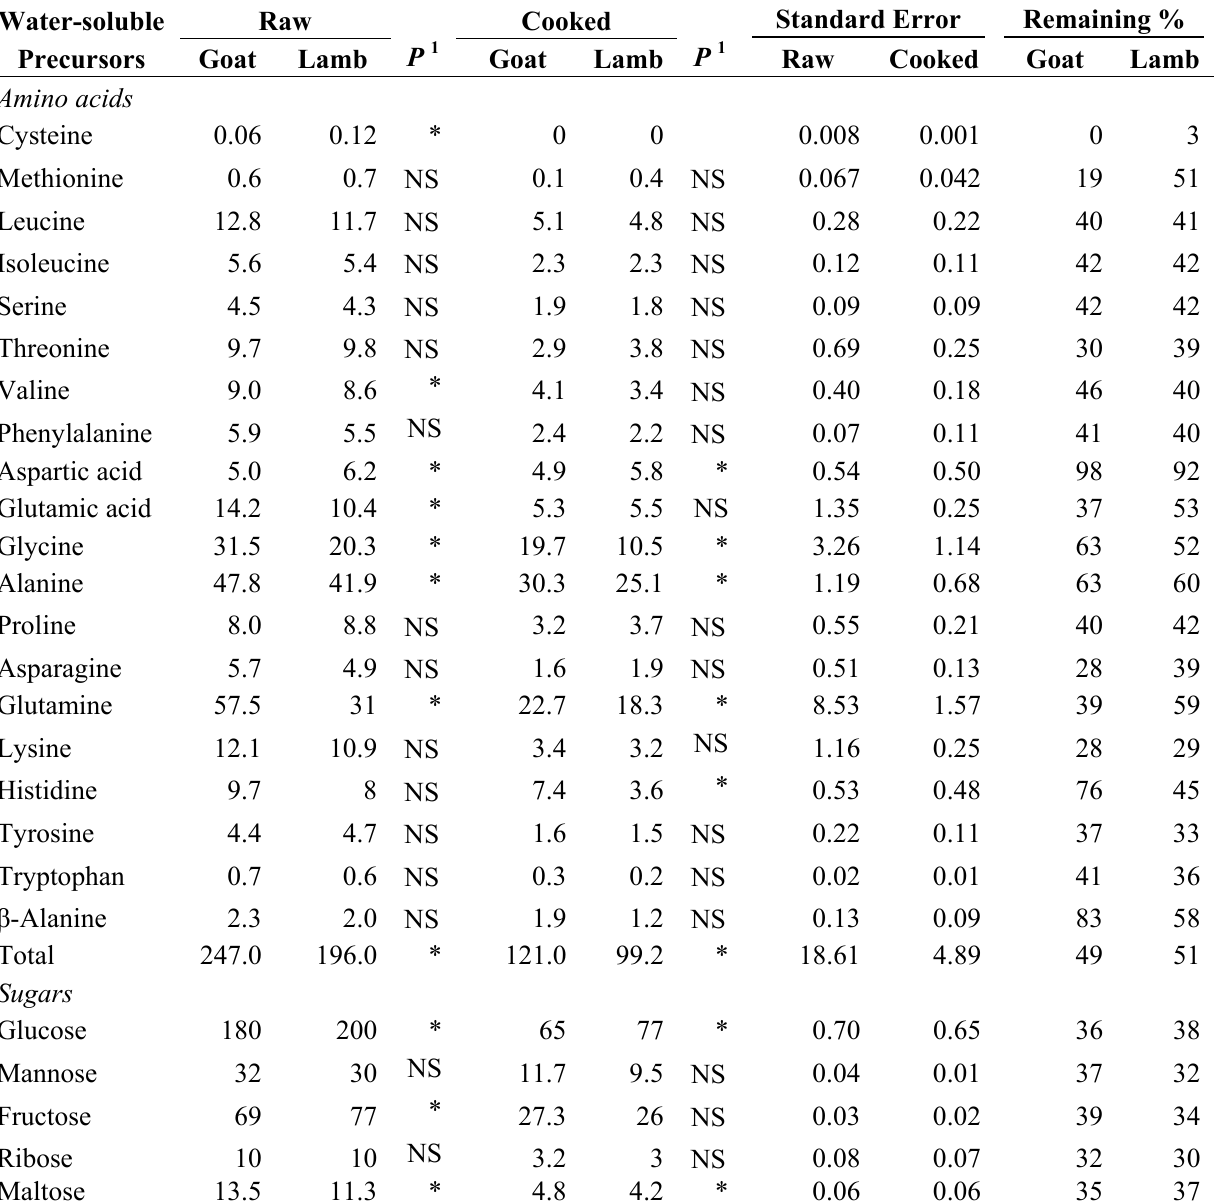
Table 2. Mean concentrations (mg·100 g − 1 wet weight) of free amino acids and sugars of Longissimus dorsi from Saanen goat and cross Suffolk lamb. Water-soluble Standard Error